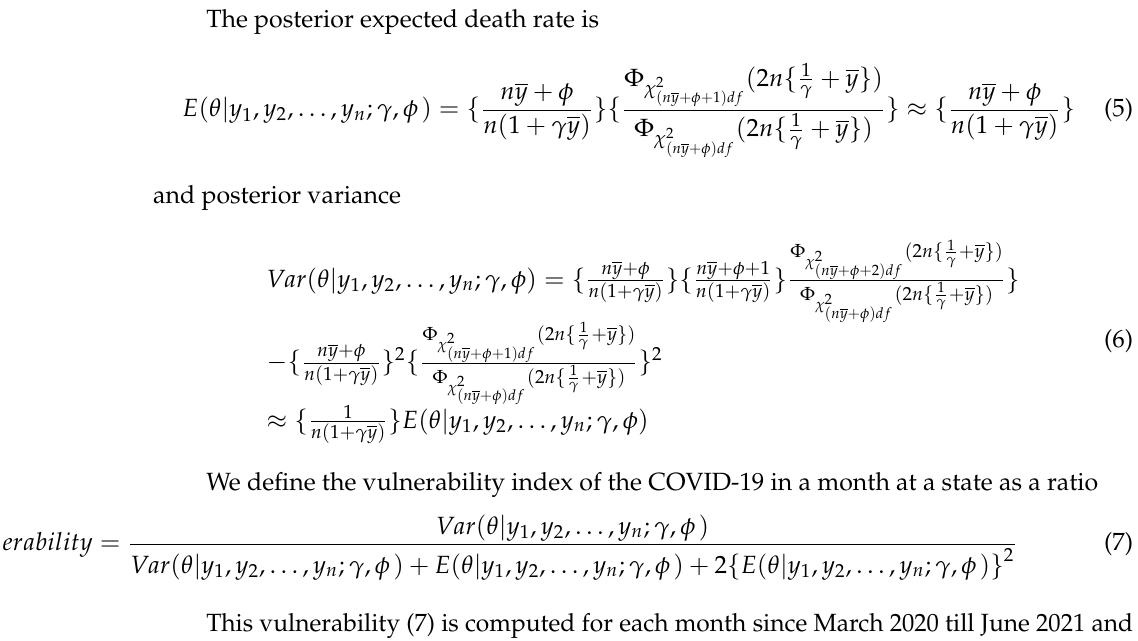
Figure 2. The graph of balancing factor